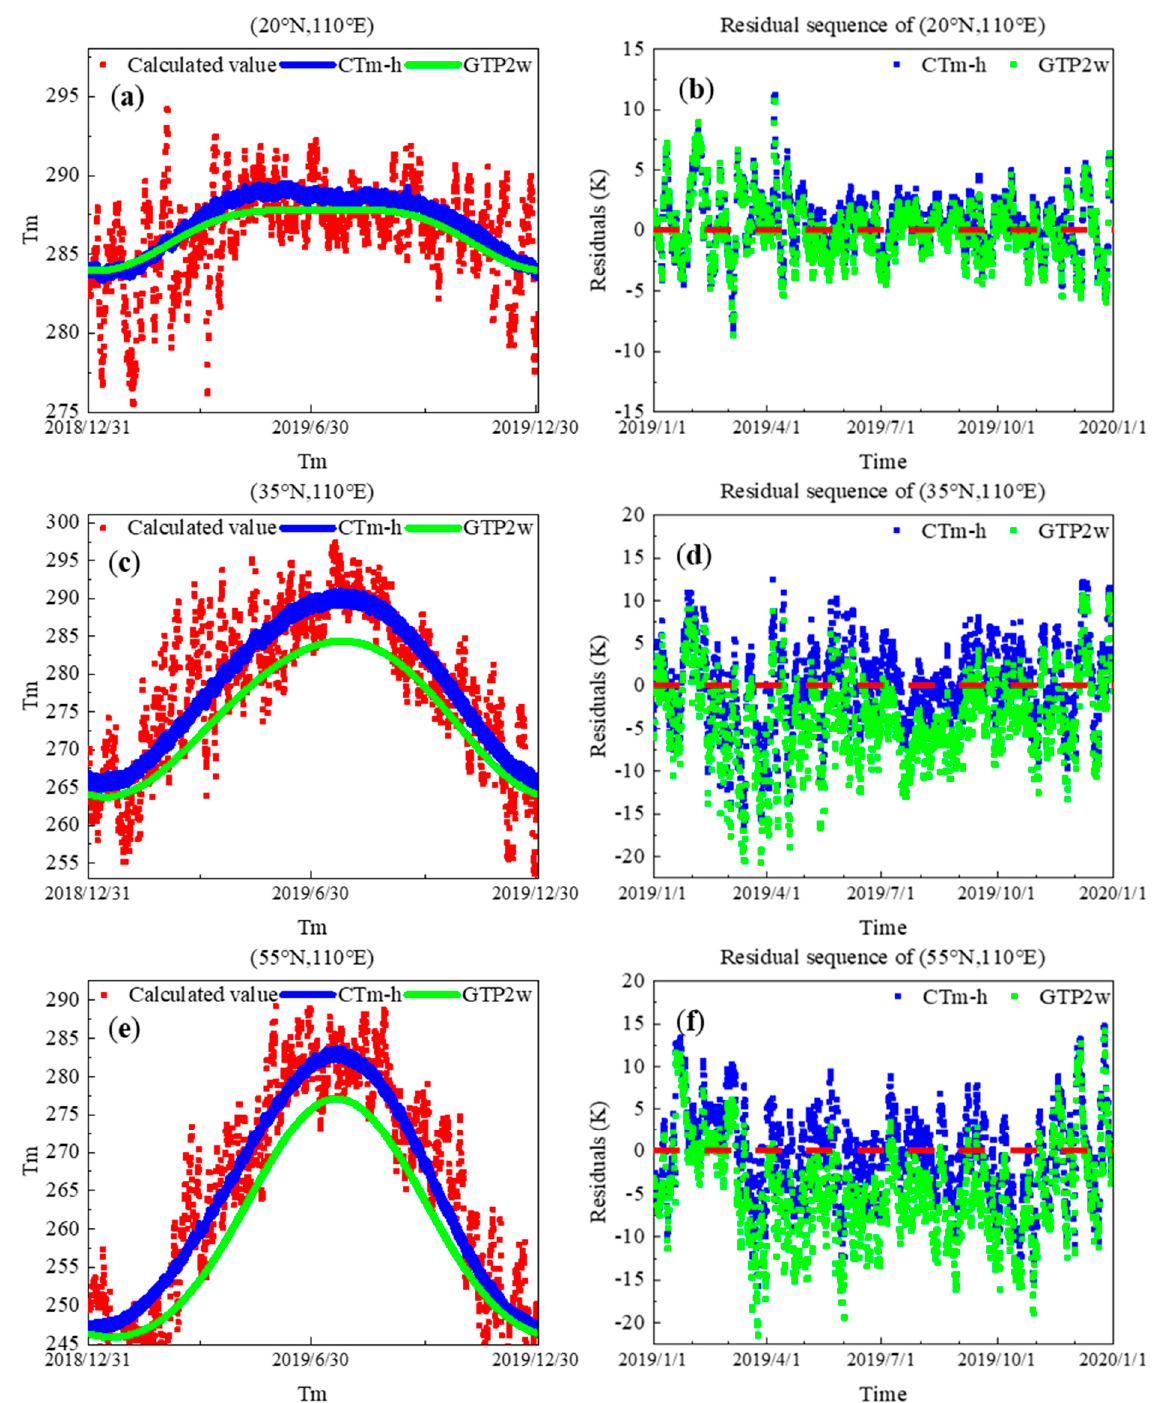
Figure 8. Fitting results ( a , c,e ) and model residuals ( b , d , f ) (20° N, 110° E); (35° N, 110° E); and (55° N, 110° E).